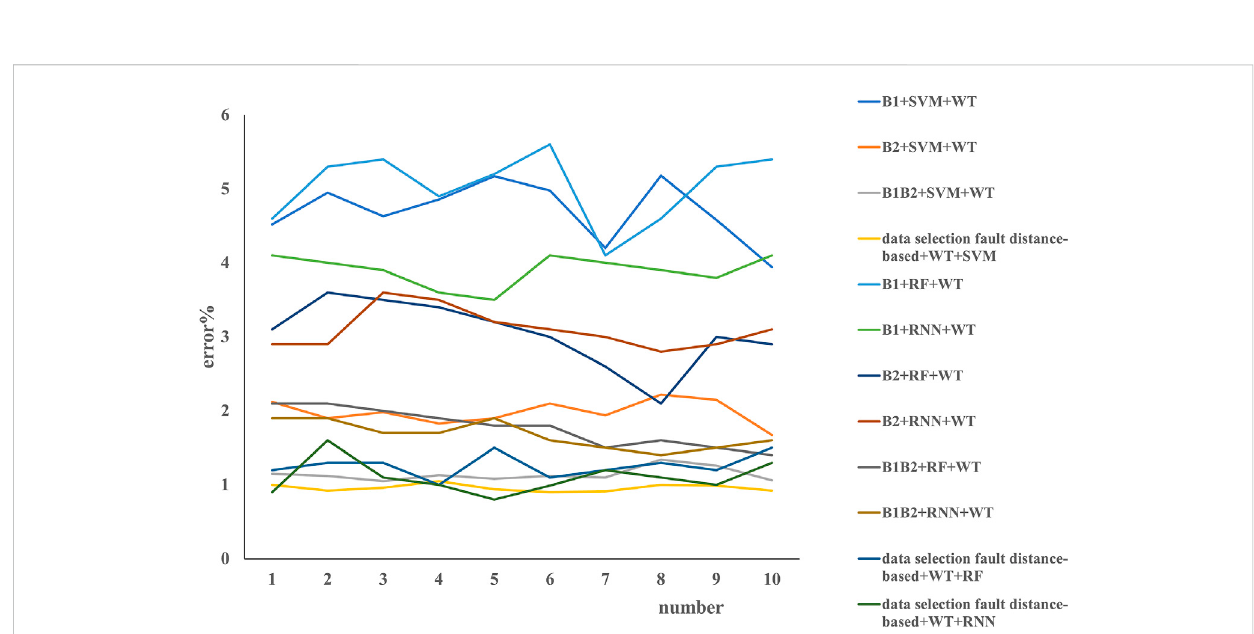
FIGURE 6 Data are located by SVM, RF, and RNN after wavelet